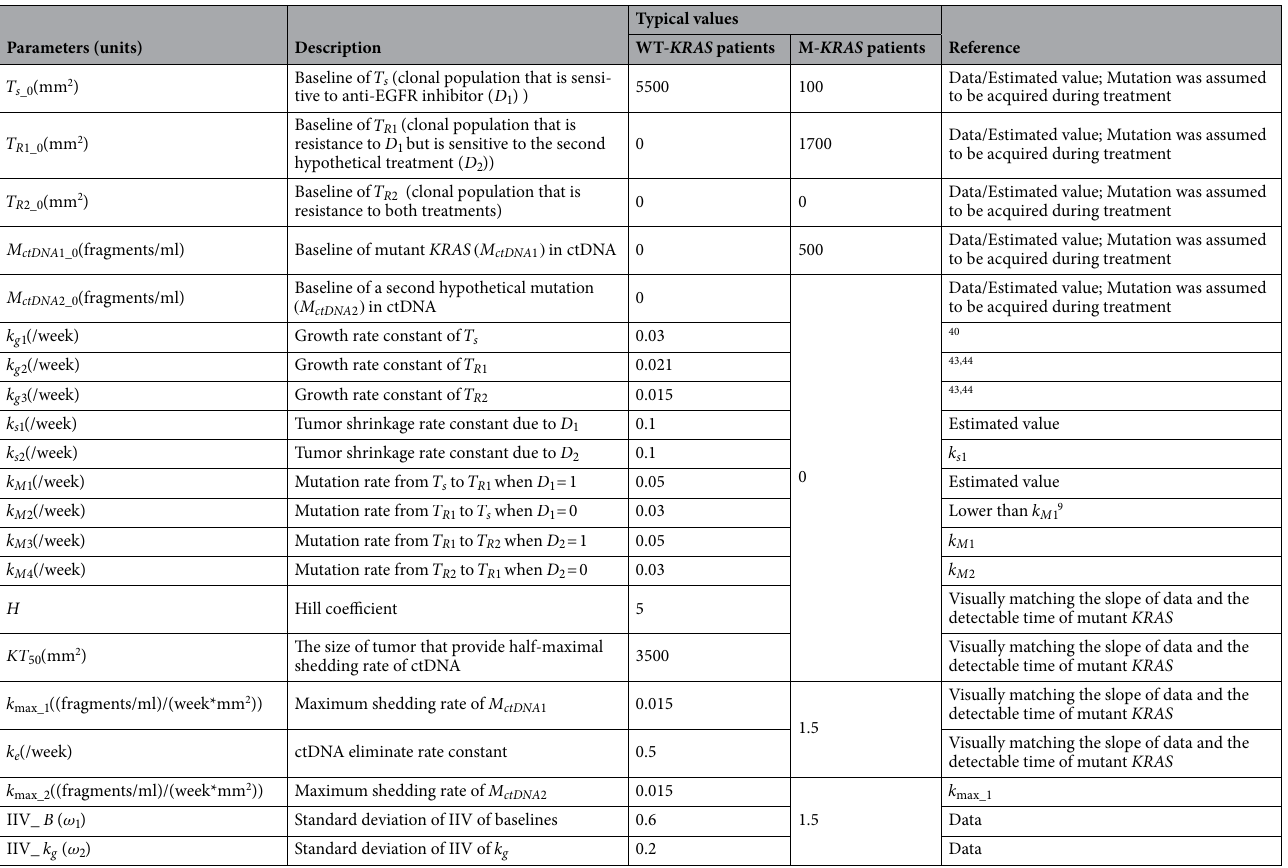
Table 1. Parameters values of the developed model characterizing the dynamics of tumor size and mutation concentrations in metastatic colorectal cancer (mCRC) patients. ctDNA, circulating tumor DNA;